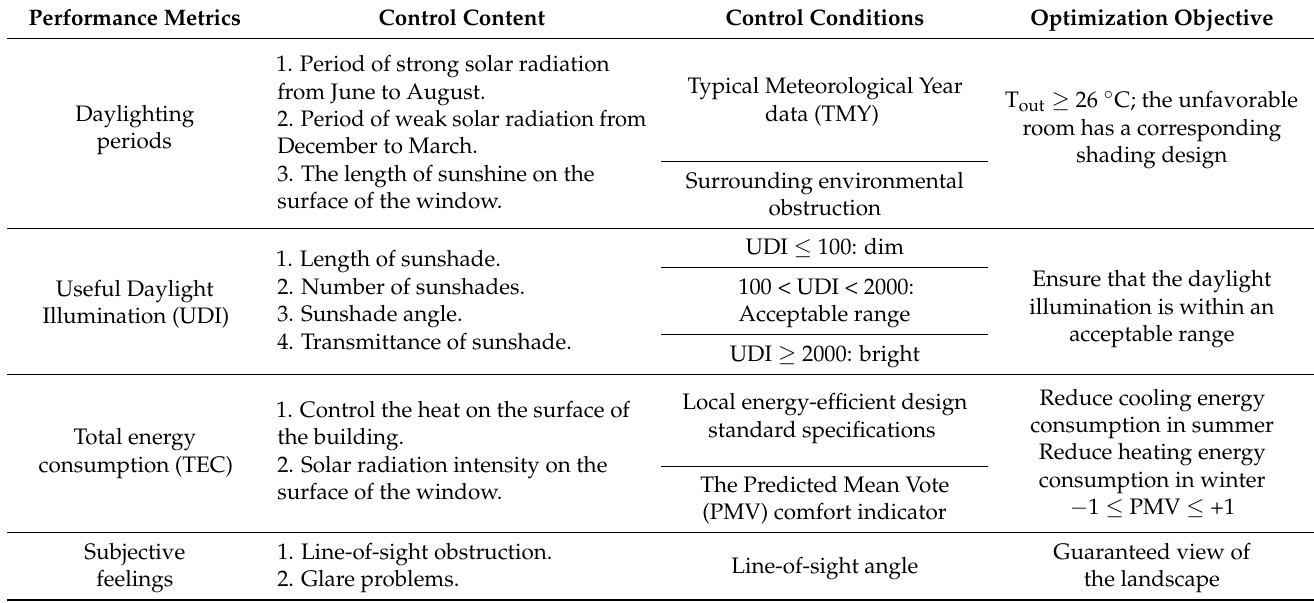
Table 2. Design Strategy and Method of shading system based on light environment.